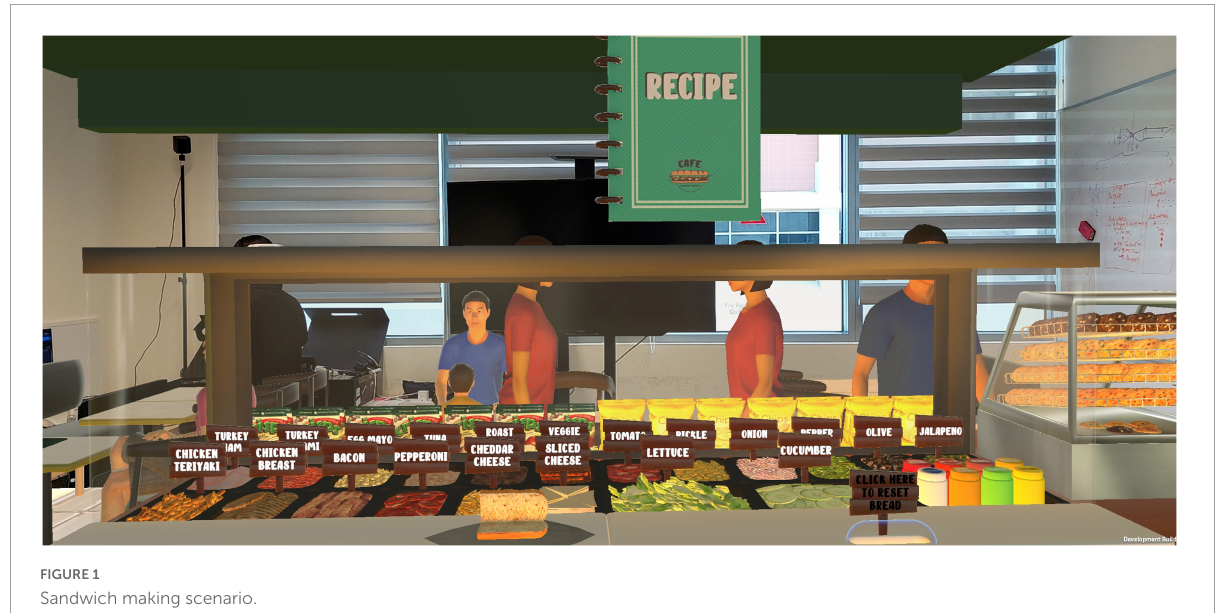
FIGURE1 Sandwich making